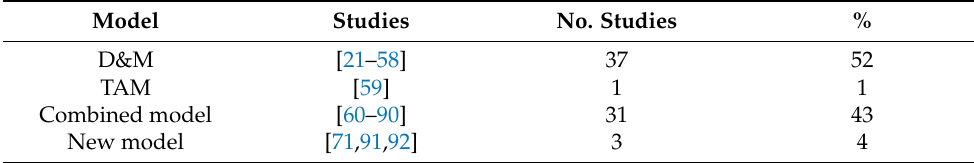
Table 1. Distribution of previous research according to the models used.